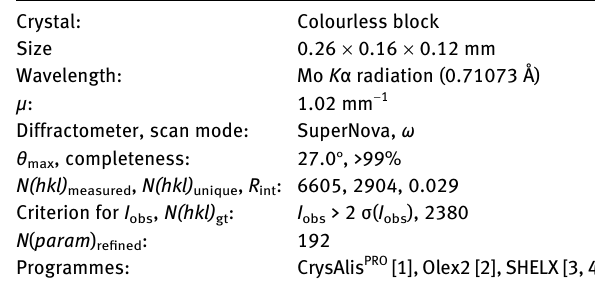
Table 1 contains crystallographic data and Table 2 contains the list of the atoms including atomic coordinates and displacement parameters.